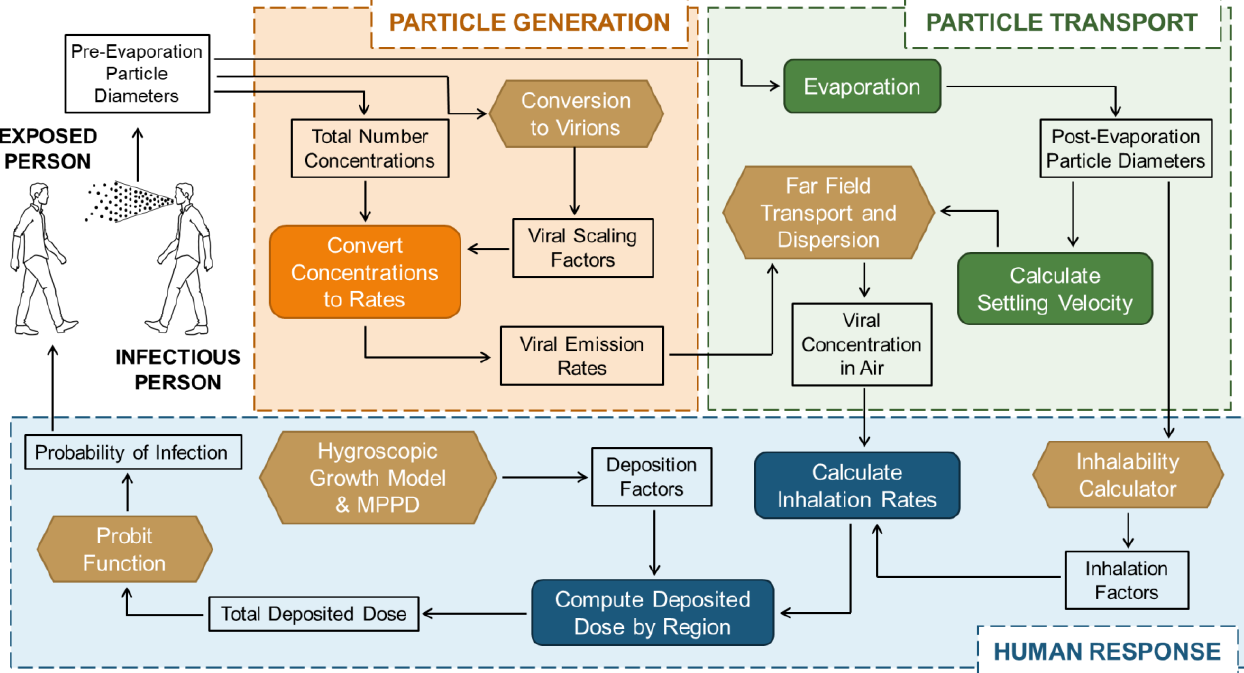
Figure 1 . End-to-end workflow of the computational framework. The probability of infection of a susceptible person is expressed as a function of particle emission by an infectious person.